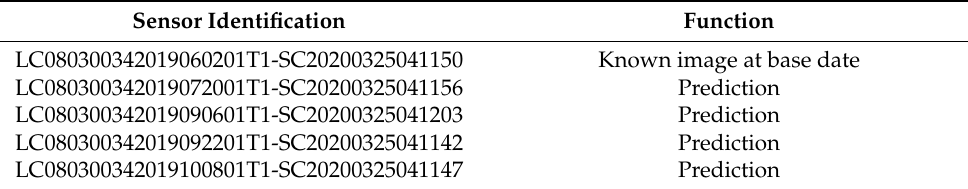
Table 2. Identifications and functions of Landsat images in Experiment